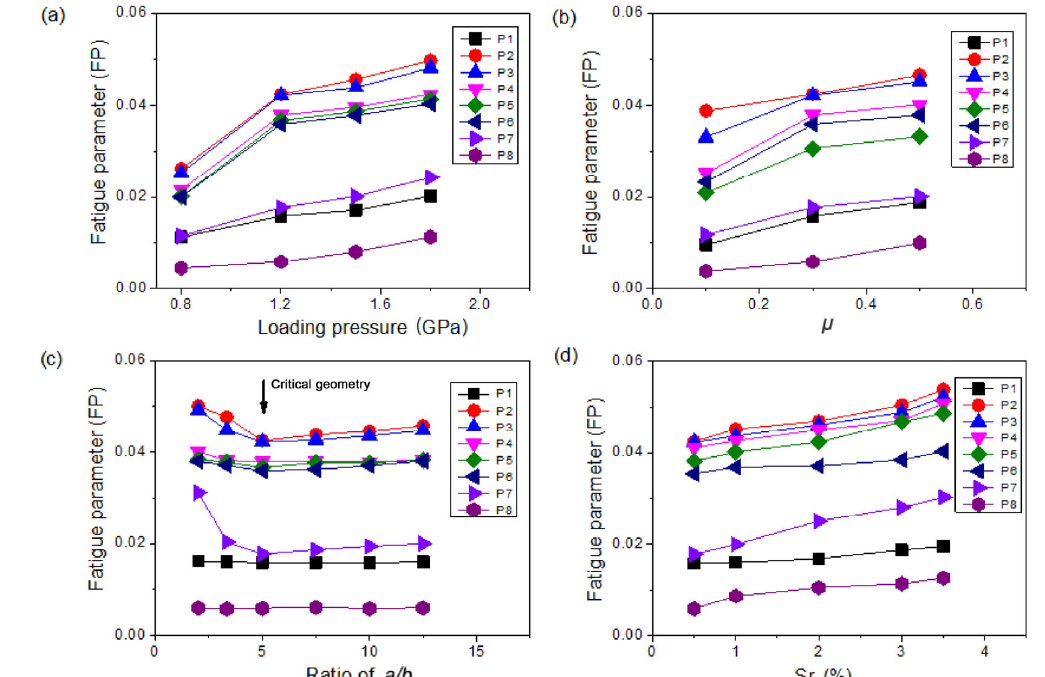
Fig. 12 Influence of (a) loading pressure, (b) μ , (c) a / b , and (d) Sr on the FPs at eight different positions for SC steel